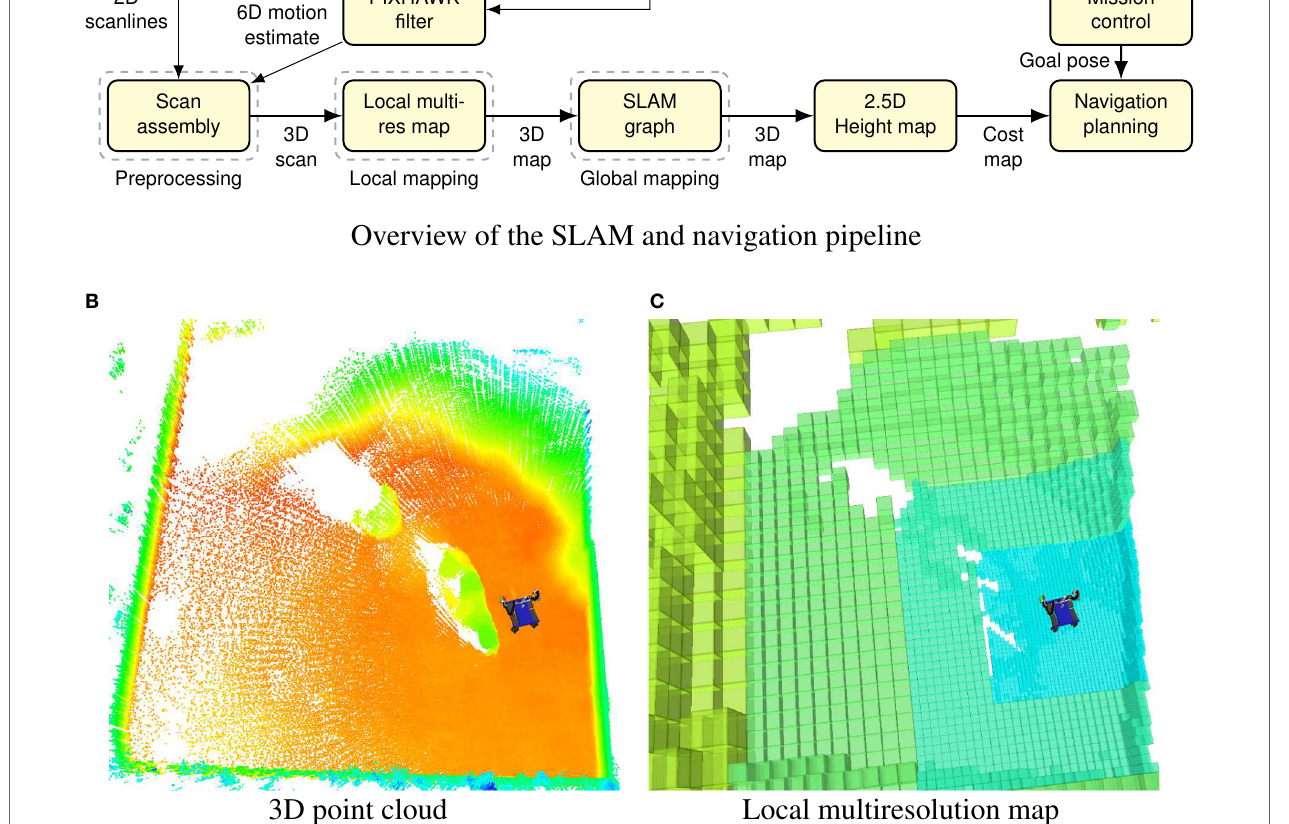
FIGURE 5 | SLAM and navigation architecture . (A) Overview of our mapping, localization, and navigation system. After filtering spurious measurements and assembling 3D point clouds (Section 5.1), measurements are aggregated in a robot-centric multiresolution map (Section 5.2) using surfel-based registration. Keyframe views of local maps are registered against each other in a SLAM graph (Section 5.3). A 2.5D height map is used to assess drivability. A standard 2D grid-based approach is used for planning (Section 6). (B) 3D points stored in the map on the robot. Color encodes height from ground. (C) The robot-centric multiresolution map with increasing cell size from the robot center. Color indicates the cell length from 0.25m on the finest resolution to 2m on the coarsest resolution.